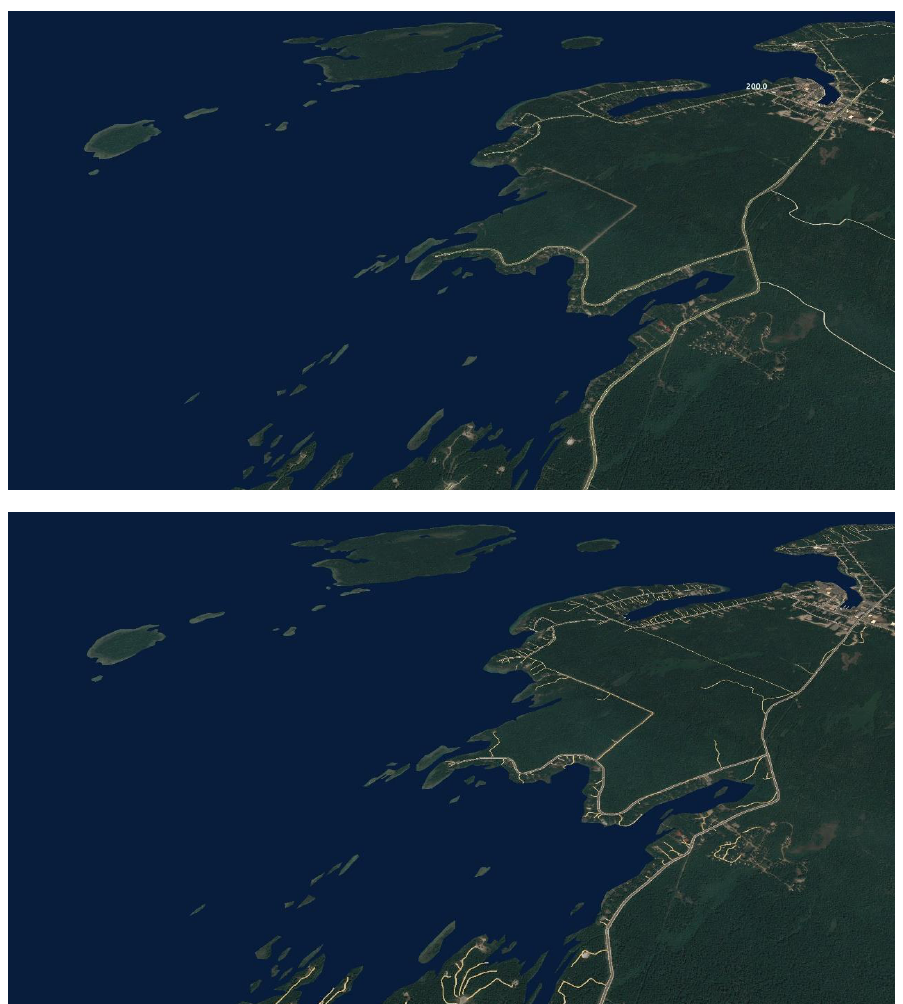
Figure 10. On the top: Proposal 1 (roads from OSM); at the bottom: Proposal 2 (road from LiDAR data detected with the implemented classification method).